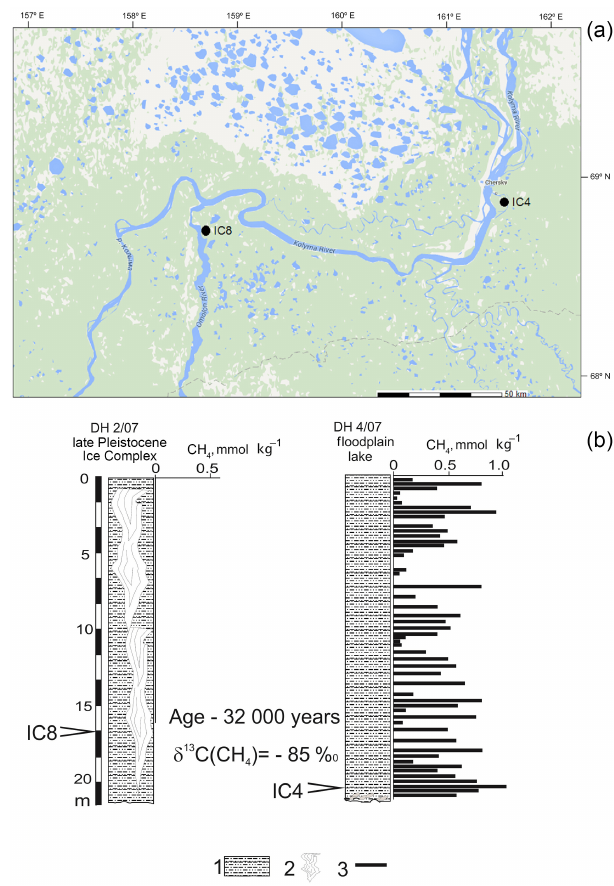
Figure 1. Location of sampling sites on the Kolyma lowland (a) . The position of samples IC4 and IC8 in drilling holes and methane content from different depth of these boreholes (b) : 1 – sandy loam; 2 – sand with gravel; 3 – ice wedges; 4 – methane